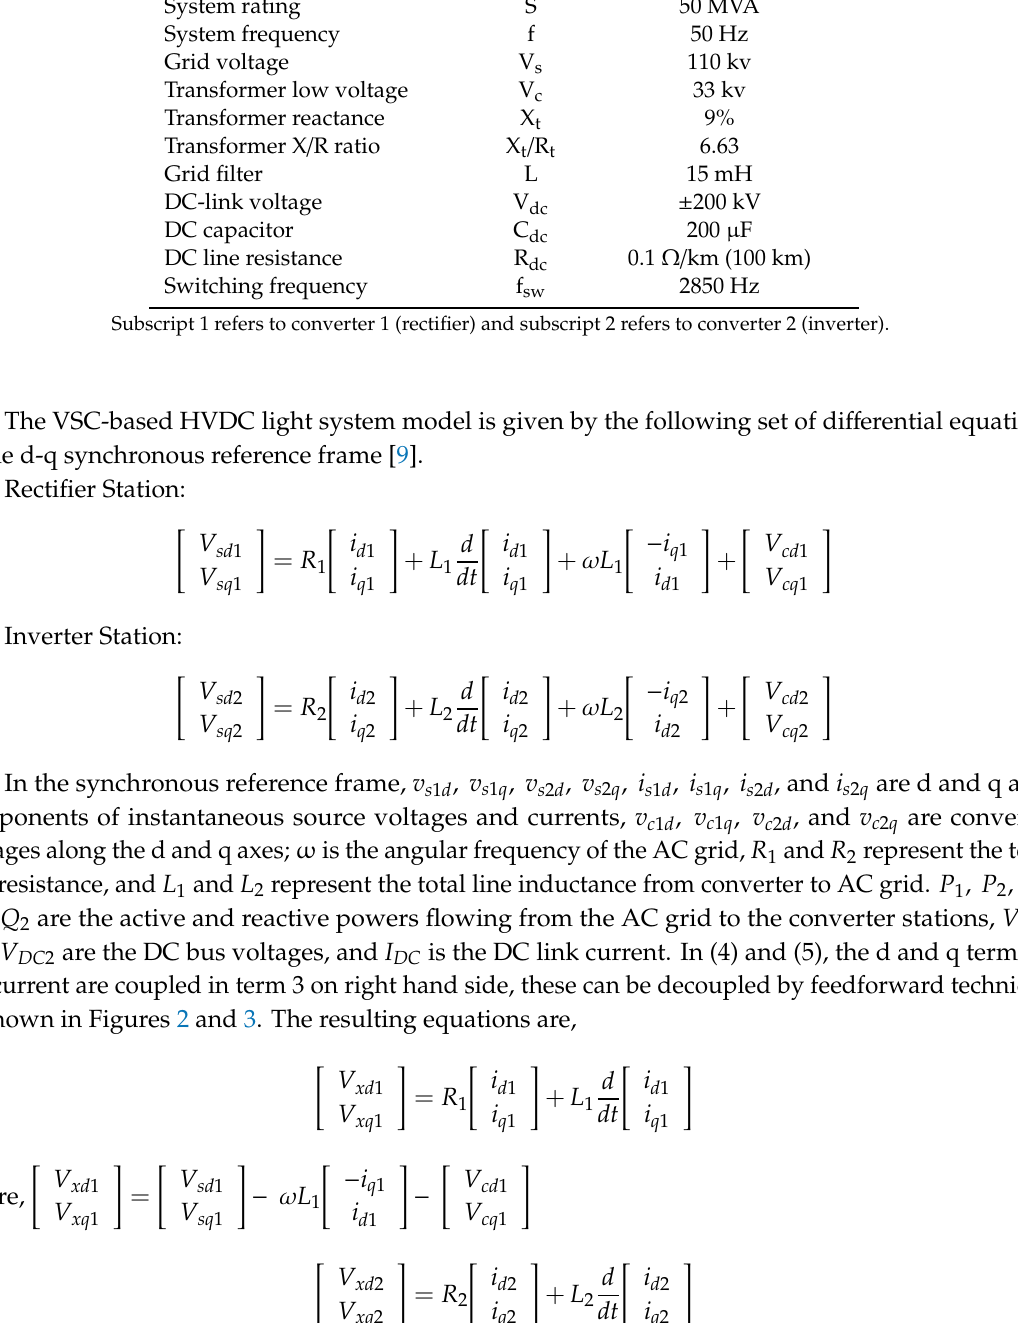
Table 1. Bidirectional VSC-based HVDC light system parameters. Parameter Symbol